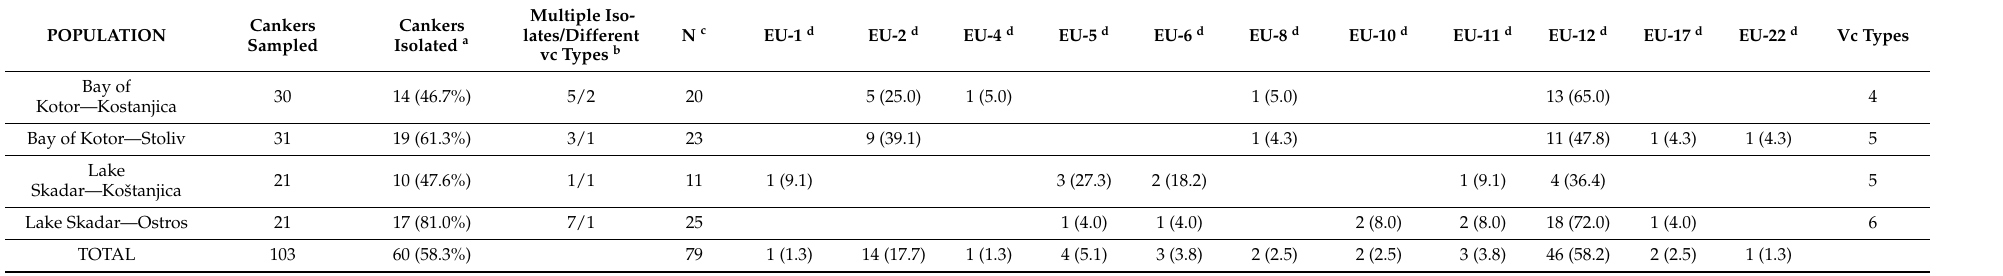
Table 2. Vegetative compatibility types of Cryphonectria parasitica isolates from four populations in